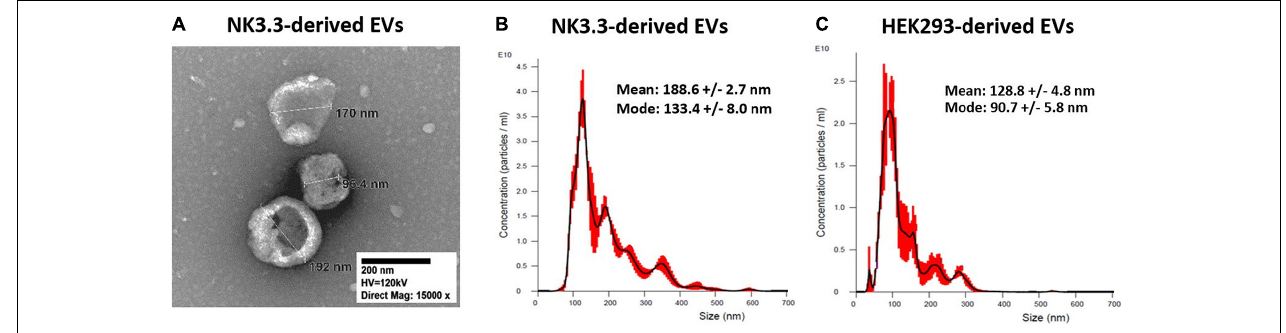
FIGURE 1 | Size characterization of EVs derived from NK3.3 and HEK293 cells. (A) TEM was used to visualize and measure the size of EVs recovered from NK3.3 cells. EVs collected from NK3.3 (B) and HEK293 (C) supernatants were evaluated by NTA to measure vesicle size and particle concentration. Data are representative of 3 measurements